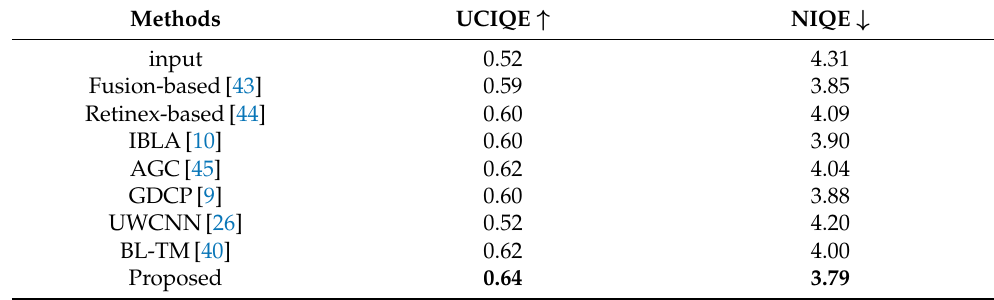
Table 1. The UCIQE[46] and NIQE[47] scores for all the compared methods on the UIEB dataset[25]. The best scores are in